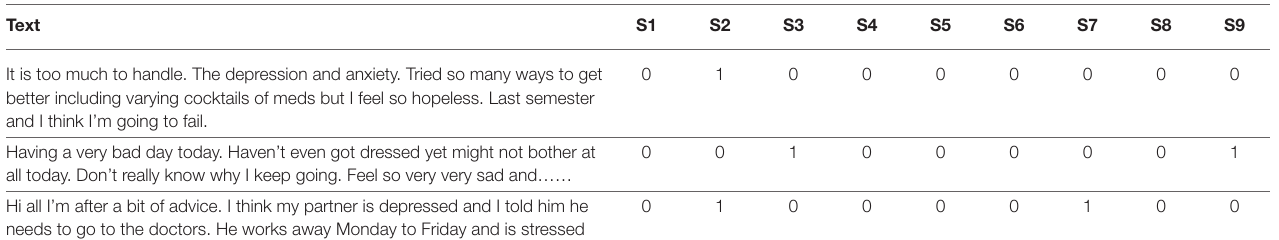
TABLE 3 | A snippets of dataset